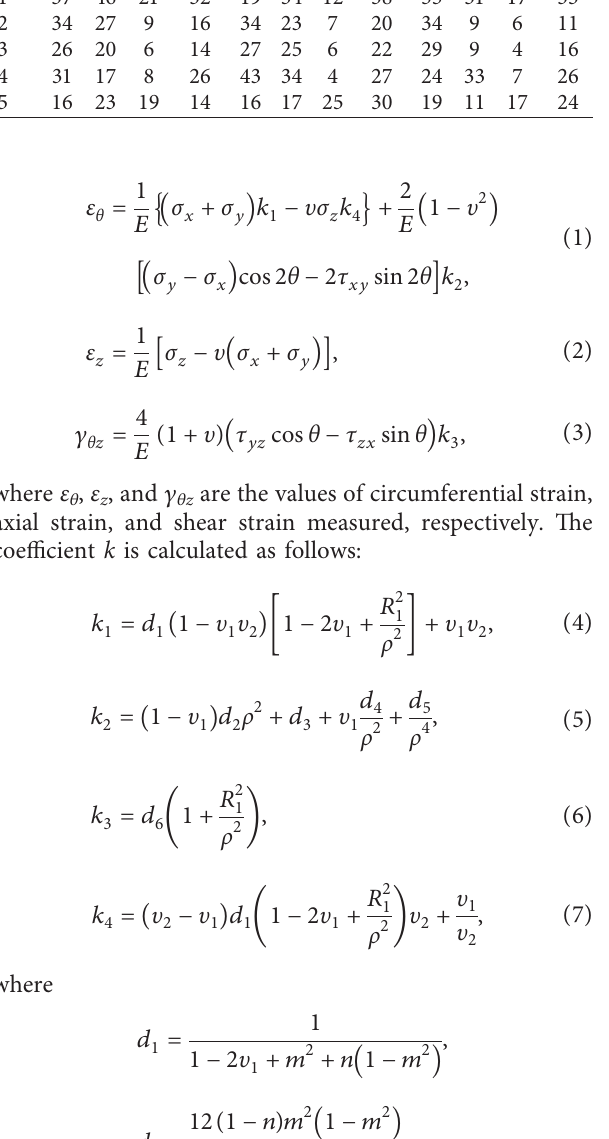
Table 3: Additional temperature strain rate of the strain gauge in each direction at each measuring point.